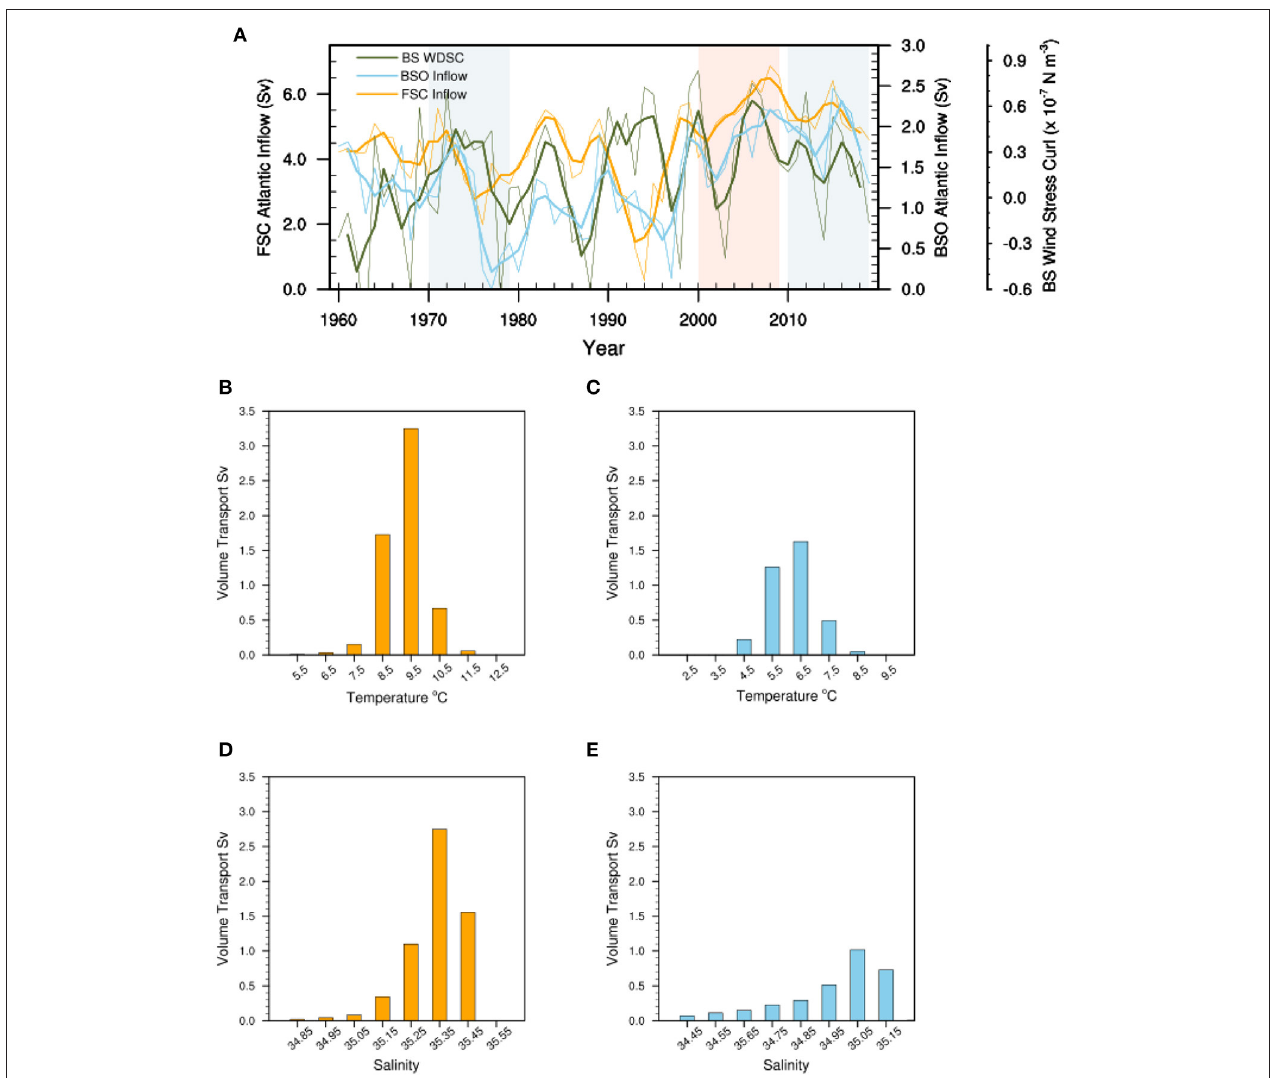
FIGURE 4 | (A) Time series of modelled Atlantic Inflow (Sv, 1 Sv = 10 6 m 3 s − 1 ) across the Faroe Scotland Channel (FSC, orange) and Barents Sea Opening (BSO, blue), and time series of wind stress curl (WDSC, green) over the Barents Sea (black box in Figure 1A ). For each of the time series shown, light lines are annual means and bold lines are three-year running mean values. The shaded time periods highlight the time periods four years after the respective decadal trends in the SPG. Atlantic Inflow is defined as the volume transport of water with eastward zonal velocity and with T > 8.5 ◦ C and S > 35.25 at the FSC, and T > 5.5 ◦ C and S > 35.0 at the BSO. Histograms of volume transport (Sv) in various temperature (T) and Salinity (S) classes across the (B,D) , FSC and (C,E) , BSO, respectively. The location of the FSC and the BSO section for computing volume transports is shown in Figure 1A